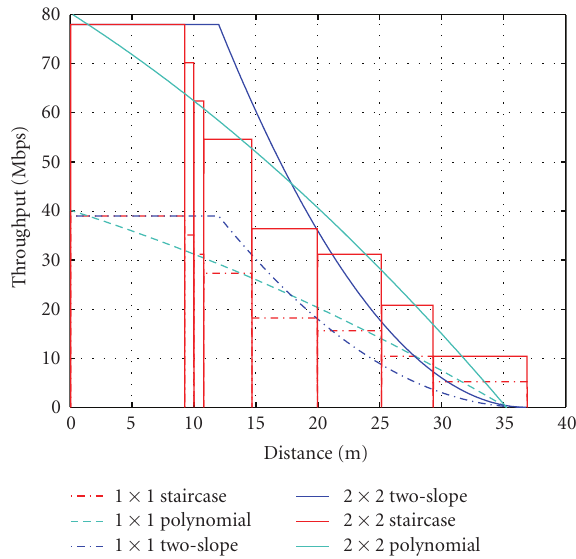
Figure 3: Theoretical Quantized and its approximated polynomial and two-slope throughput distance